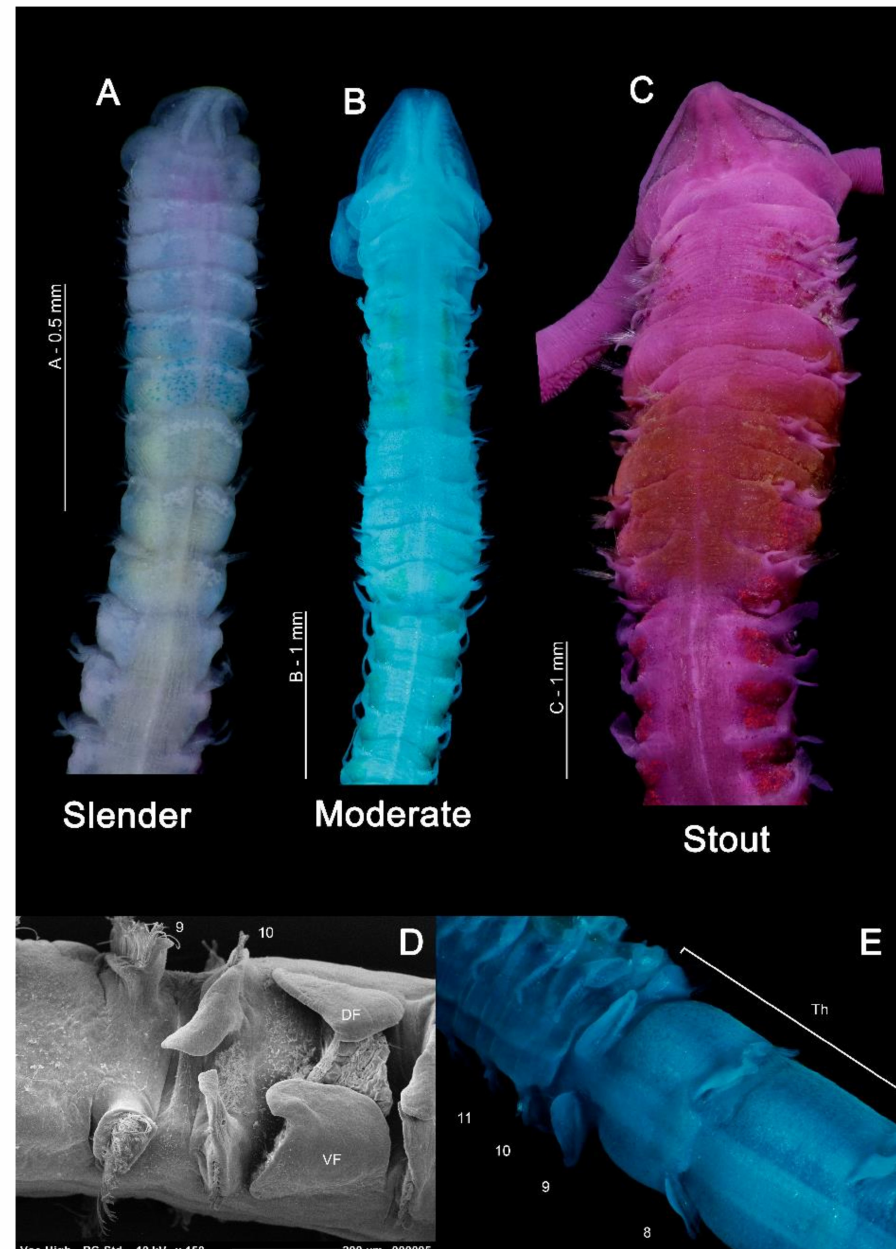
Figure 3. ( A ) Anterior of Magelona minuta (dorsal view, specimen stained with rose bengal and methyl green); ( B ) anterior of M. mahensis (dorsal view, stained with methyl green); ( C ) anterior of M. alleni , showing distinct pigment band between chaetigers 5–8 (dorsal view, stained with rose bengal); ( D ) thoracic/abdominal junction of M. johnstoni (lateral view), showing an anteriorly open pouch between chaetigers 10 and 11; ( E ) thoracic/abdominal junction of M. johnstoni (dorsal view). Abbreviations: DF—dorsal flap, Th—thorax, VF—ventral flap. Numbers indicate